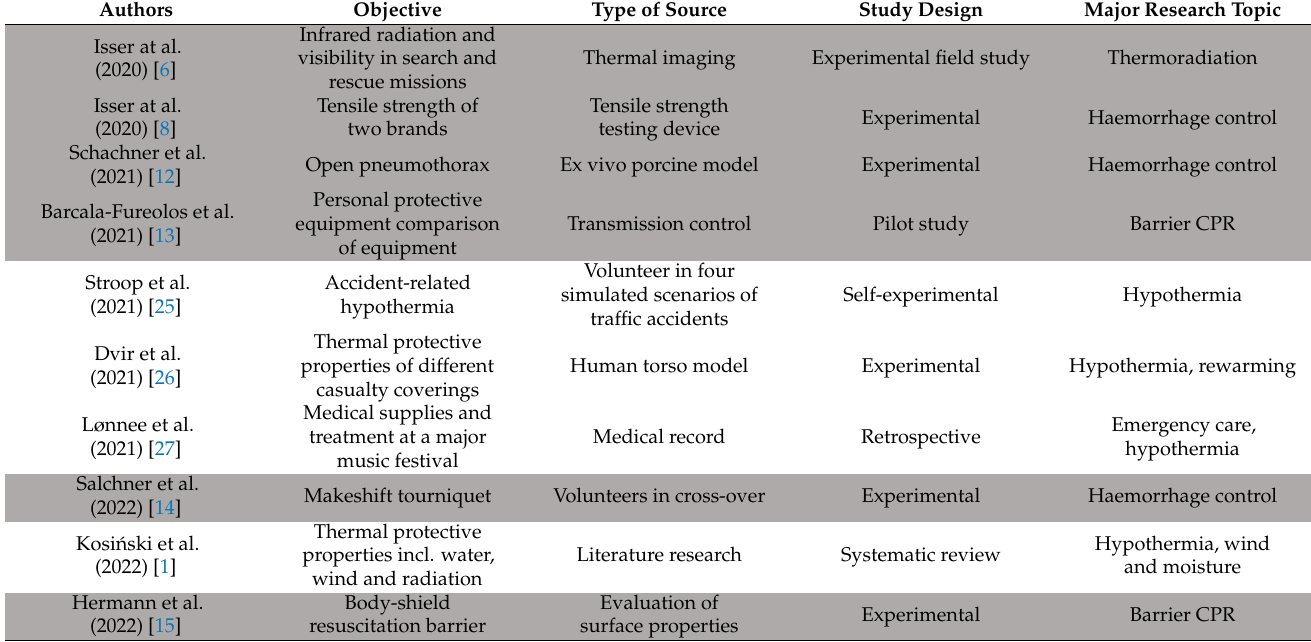
A figure-of-eight bandage is used to disconnect the overlying fragments of a frac- tured clavicle. Furthermore, the figure-of-eight bandage stabilizes and immobilizes the shoulder joint through pulling both shoulders backwards. This forces the patient into a straight-backed posture. When the fragments of the fractured clavicle are separated by traction, pain is relieved instantly. Andersen et al. observed that patient satisfaction was lower with the figure-of-eight bandage [30]. Healing was not affected, and functional out- come did not differ between the two types of immobilizations. The authors prefer the broad arm sling to the figure-of-eight bandage because of the rapid reduction of pain, the ease of handling and the more efficient immobilization during transport in the pre-hospi- tal setting [31].